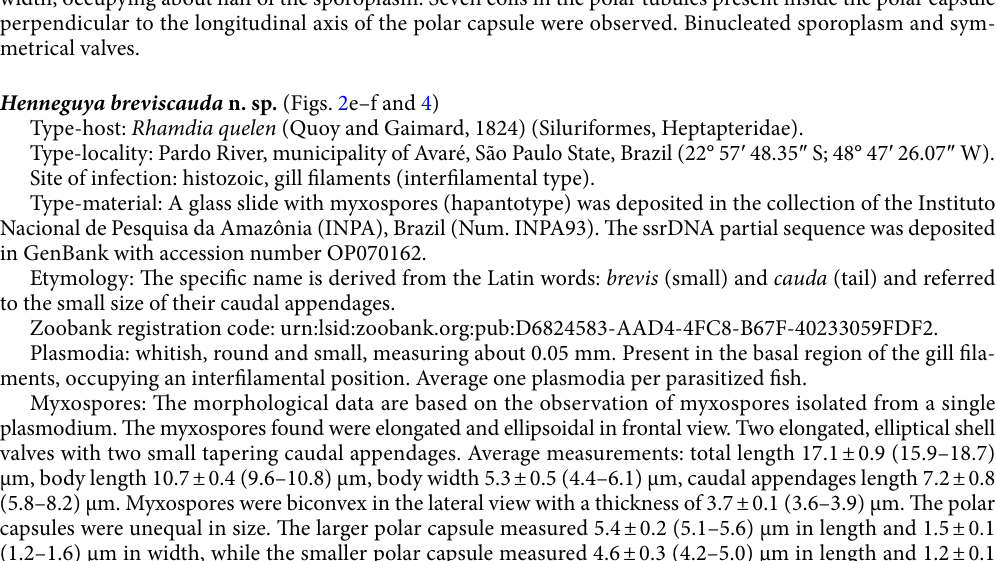
Plasmodia: whitish, elongated, occupying the inner region of the primary gill filament (intralamellar), meas- uring about 3 mm. Average one plasmodia per parasitized fish. Myxospores: The morphological data are based on the observation of myxospores isolated from a single plasmodium. The myxospores found were elongated and ellipsoidal in frontal view. Two elongate, elliptical shell valves with two medium tapering caudal appendages. Average measurements: total length 20.9 ± 0.9 (19.2–21.8) µm, body length 11.2 ± 0.5 (10.5–12.4) µm, body width 5.1 ± 0.3 (4.6–6.1) µm, caudal appendages length 9.8 ± 0.9 (8.2–11.1) µm. Myxospores were biconvex in the lateral view with a thickness of 3.8 ± 0.2 (3.6–4.1) µm. The polar capsules were equal in size and measured 5.9 ± 0.6 (4.9–6.7) µm in length and 1.6 ± 0.1 (1.4–1.8) µm in width, occupying about half of the sporoplasm. Seven coils in the polar tubules present inside the polar capsule perpendicular to the longitudinal axis of the polar capsule were observed. Binucleated sporoplasm and sym- metrical valves.